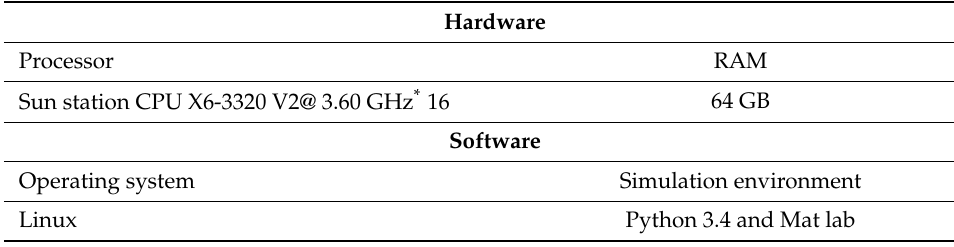
Table 3. Environment.